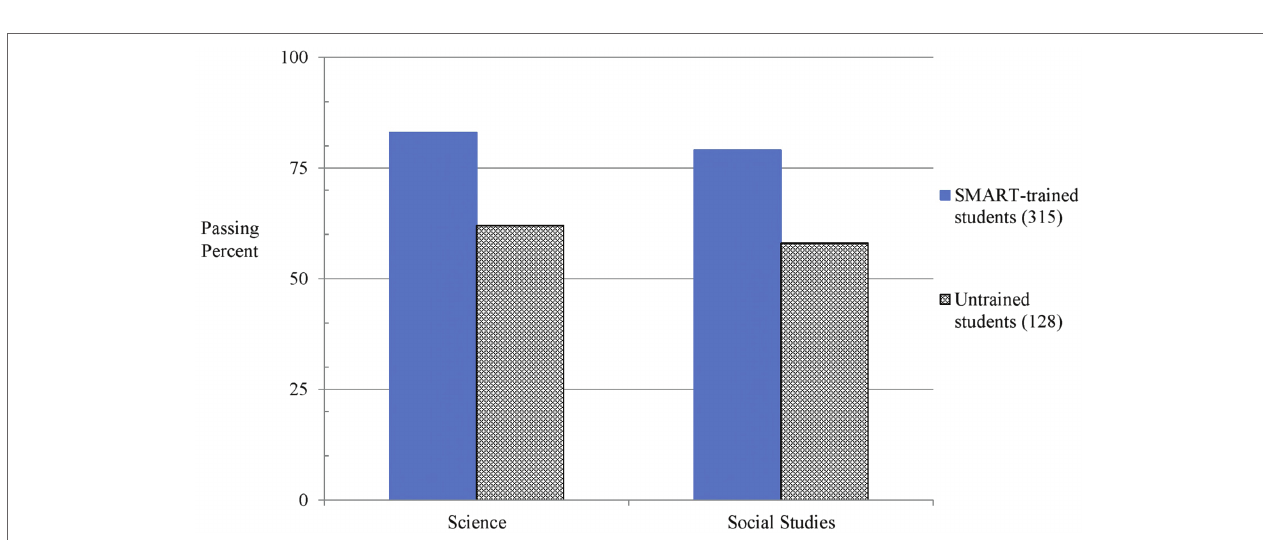
FIGURE 2 | Passing rates are shown for trained and untrained groups on the STAAR Math test for seventh graders in the year before training and the next year in eighth grade 4 months after training. Similar to the reading outcomes, the difference between the groups is larger following training, with more students from the trained group passing the math test.